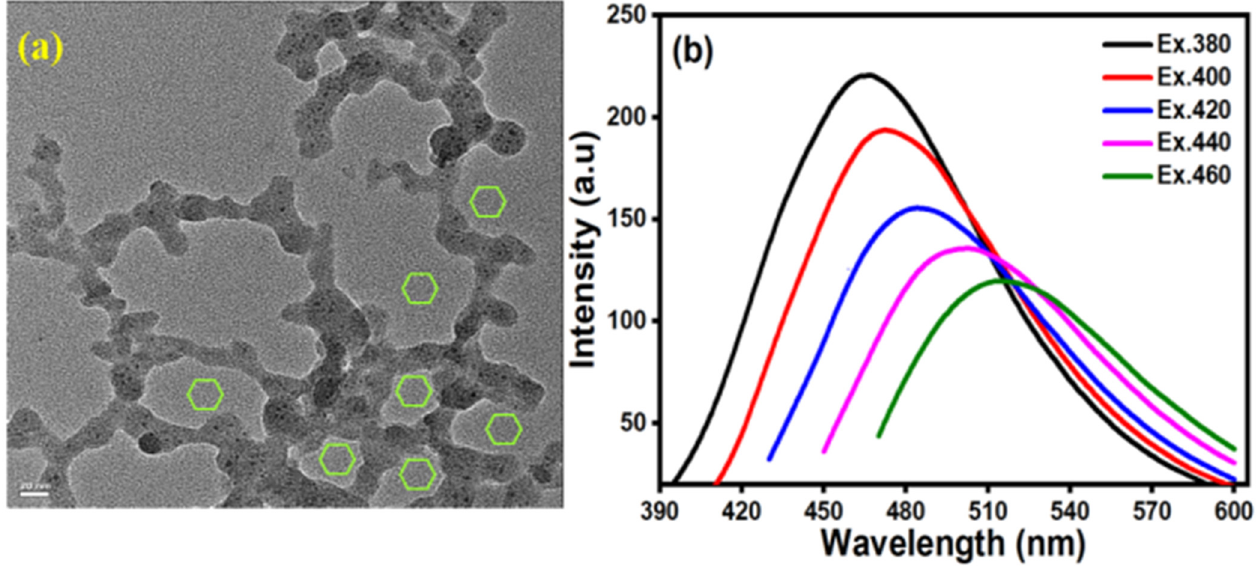
Figure 4. ( a ) TEM image of PANI-N@CDs; ( b ) fluorescence spectra of PANI-N@CDs.